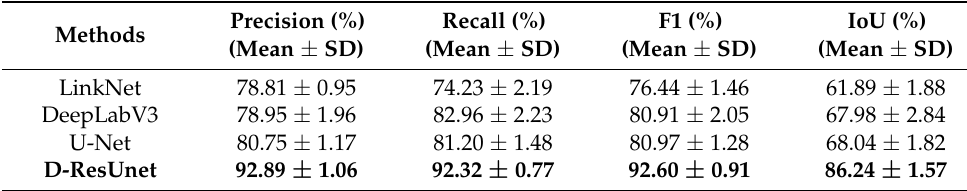
Table 4. Precision, Recall, F1, and IoU of the models (Mean ± SD 1 ).